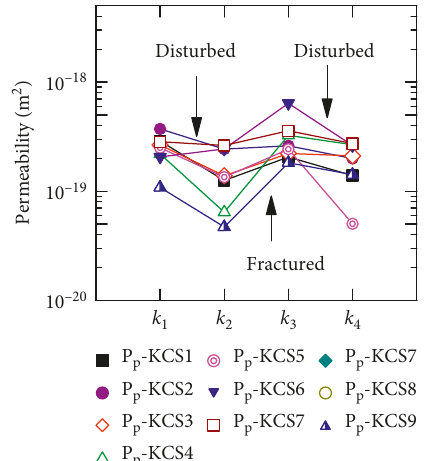
Figure 13: Permeability variation due to pore pressure disturbances and triaxial compression under P